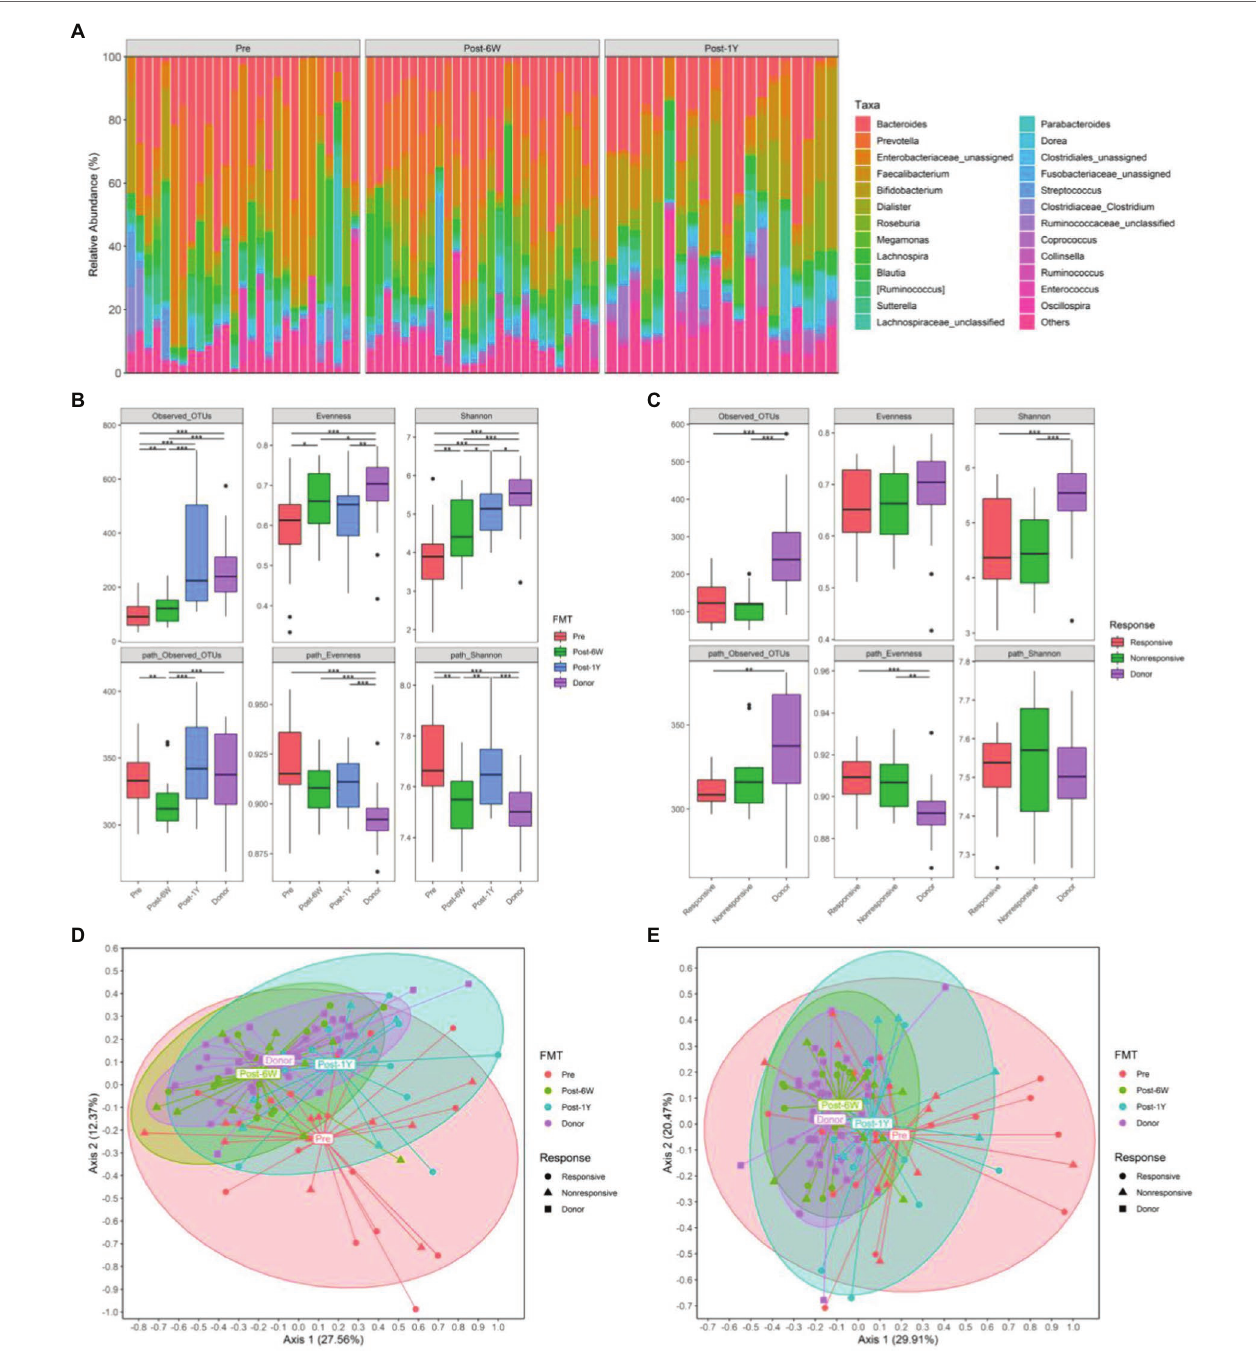
FIGURE 3 | The gut microbiota from all patients. (A) The relative abundance of gut microbiota in each patient throughout the clinical study. (B) The alpha diversities of all patients and donors throughout the clinical study. (C) The alpha diversities of responsive patients, non-responsive patients, and donors 6 weeks after FMT. (D) PCoA based on weighted UniFrac matrix of bacterial taxonomy. (E) PCoA based on Bray-Curtis matrix of predicted pathways. Boxplots present the median and interquartile range (25–75th percentiles) for each group with whisker length equal to 1.5 interquartile range. Statistically significances are also indicated: * p < 0.05, ** p < 0.01, and *** p <